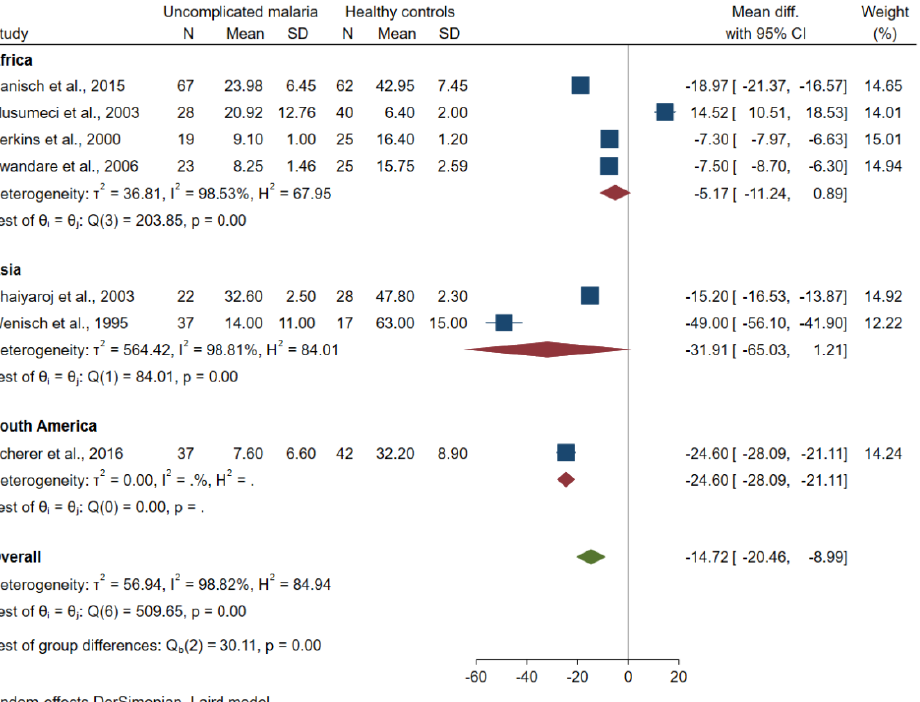
Figure 3. Forest plot demonstrating a difference in mean TGF-β levels (pg/mL) in uncomplicated malaria and healthy controls by continents [26,27,33,38–40,42]. Grey y -axis line, line of no effect size; blue square boxes, mean TGF-β levels from each study; line on the left and right of blue square boxes, 95% CI; green diamond; overall effect size; crimson diamond, overall effect size in each subgroup; I 2 , H 2 and τb 2 , heterogeneity measures.